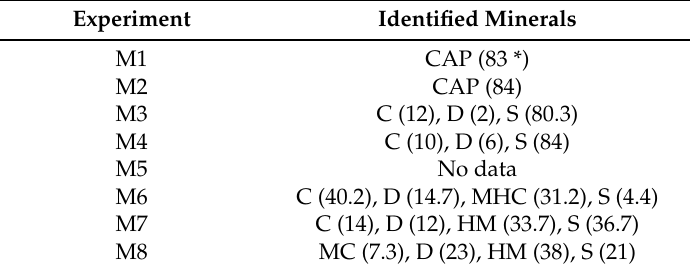
Table 3. Mineralogy of the bioliths derived from XRD analysis.